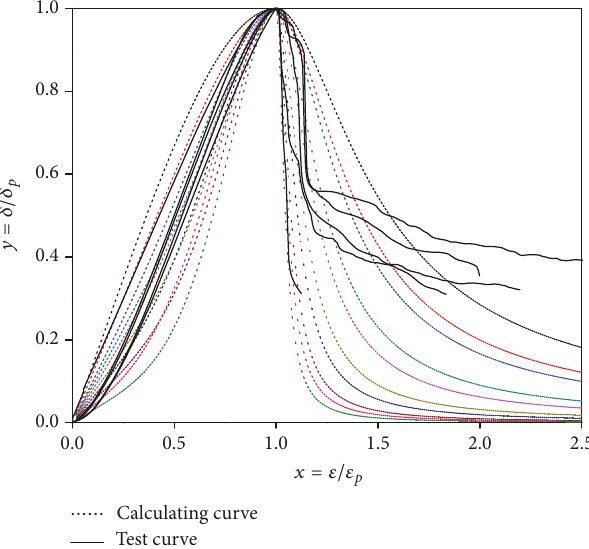
Figure 15: The integrated calculating curve in contrast to the complete test curve. The colored dotted lines referred to the incorporation of calculated results in Figures 11 and 13.